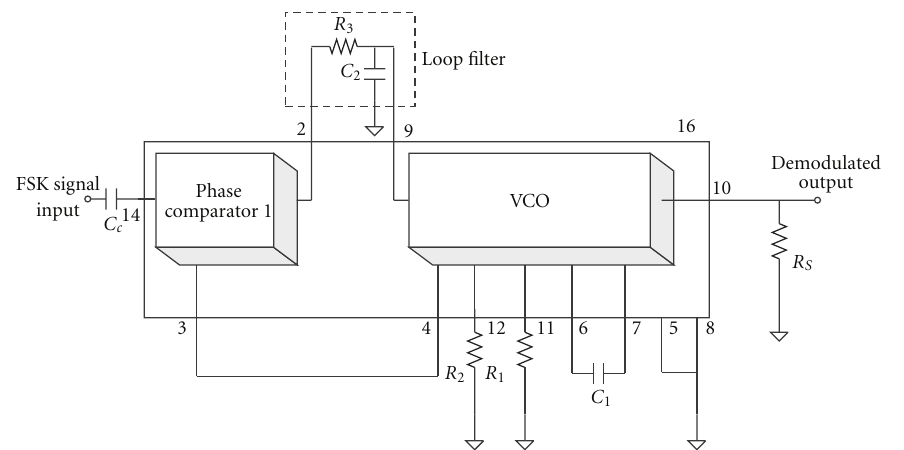
Figure 6: Schematic diagram of the demodulator.